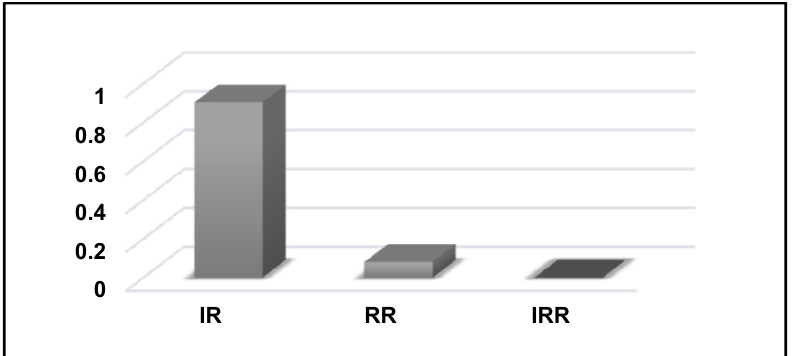
Figure 24. Mean results of schema metrics for the evolved ontology-based models using the On- toMetrics tool.